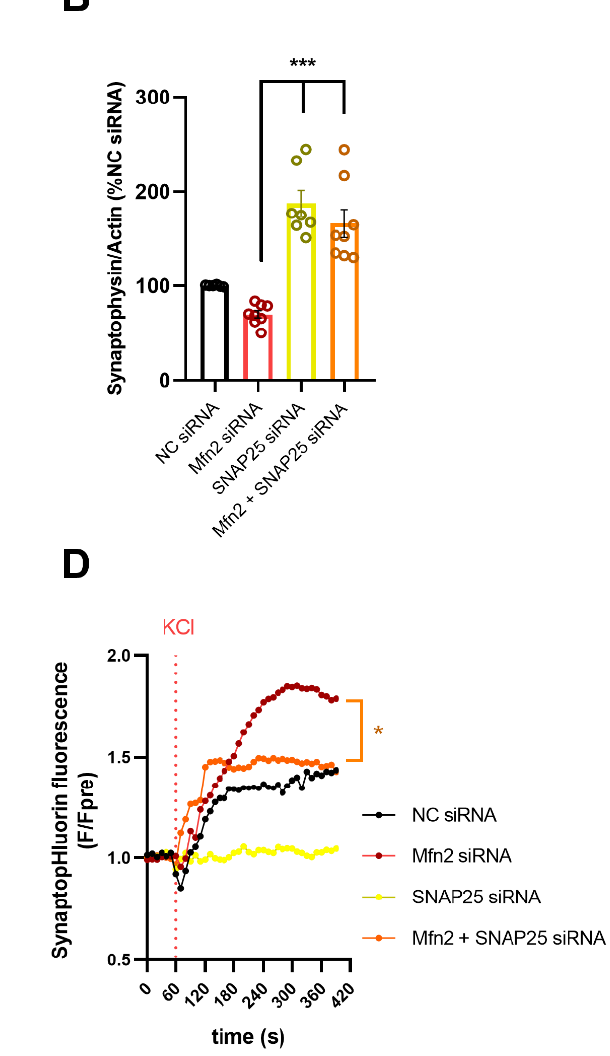
Figure 3. SNAP25 KD rescues Mfn2 KD-mediated vesicle marker downregulation and decreases SypHy fluorescence and exocytosis upon cellular depolarization ( A ) Representative immunoblots of NC siRNA, Mfn2 siRNA, SNAP25 siRNA and Mfn2+SNAP25 siRNA SH-SY5Y cells. Blots were probed with antibodies against Mfn2, synaptophysin and actin which was used as a loading control. ( B ) Bar graph shows the amounts of synaptophysin protein once standardized to actin content in each sample ( n = 8 independent cultures) ( C ) Representative confocal images of Mfn2 siRNA or Mfn2+SNAP25 siRNA SH-SY5Y cells. Panels show initial fluorescence (F 0 ) and final fluorescence (F f ). Scale bar = 10 µ m ( D ) Graph shows normalized SypHy fluorescence over time in NC siRNA, Mfn2 siRNA, SNAP25 siRNA and Mfn2+SNAP25 siRNA, each timepoint (F) was normalized to average pre-stimulation fluorescence levels (F pre ). After one minute of basal recording, cells were depolarized with 50 mM KCl ( n = 11–22 cells from 5 independent cultures). The ratiometric difference between Mfn2 siRNA and Mfn2+SNAP25 siRNA F f /F 0 was shown to be significant p ≤ 0.05. Data shown as mean ± SEM. * p ≤ 0.05, *** p ≤ 0.001 .